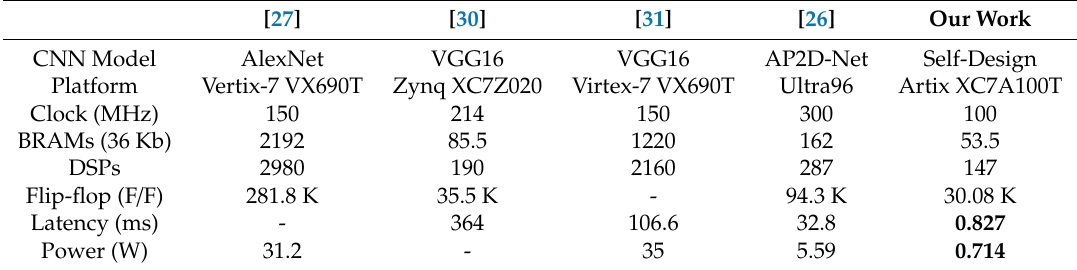
Table 4. Comparison with previous FPGA-based CNN